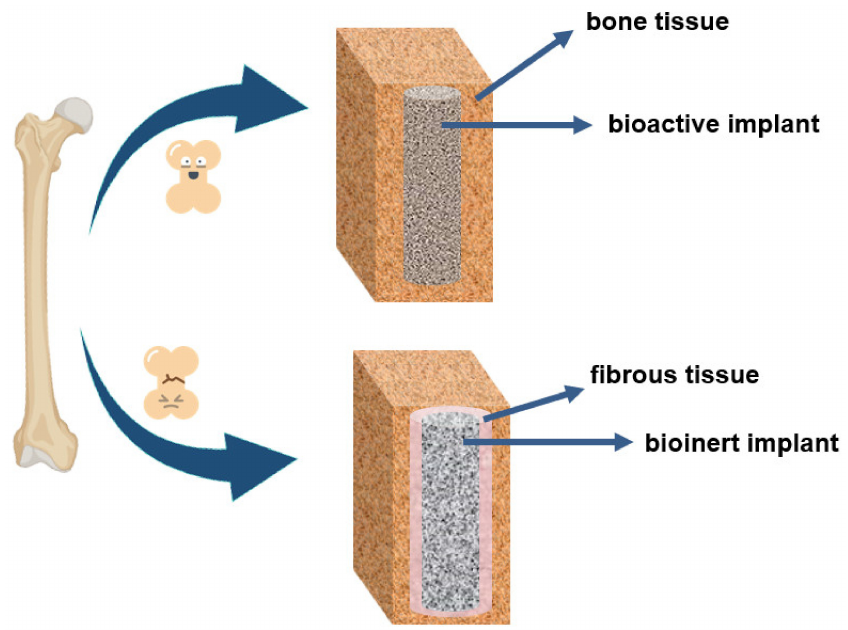
Figure 9. Body response to a bioactive and bioinert